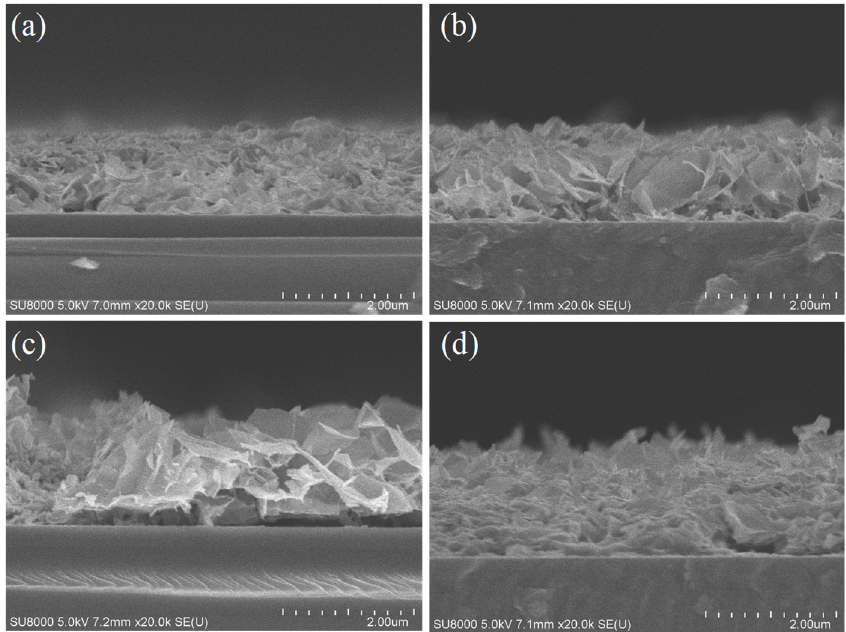
Figure 6. Comparison of ZnO nanostructure cross-sectional SEM images prepared on 40 nm Al AZO under different growth times ( a ) 45 min ( b ) 90 min ( c ) 180 min ( d ) 270 min.